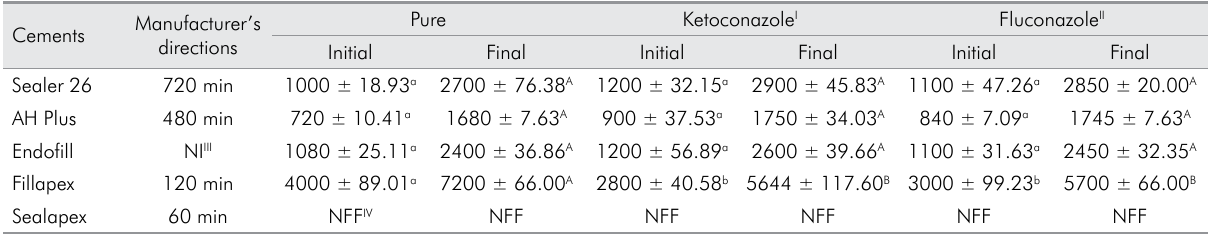
Table 4. Mean and standard deviation of setting times in minutes of sealers, pure and following addition of ketoconazole and fluconazole. Cements